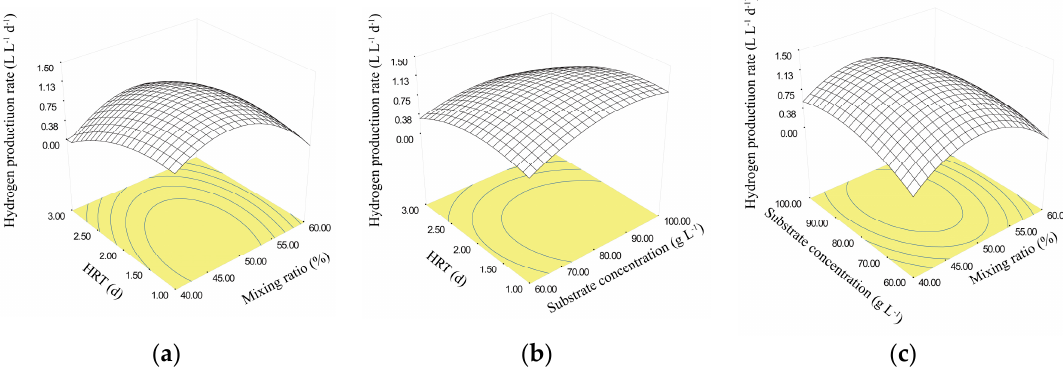
Figure 1. Three-dimensional (3D) response surface and two-dimensional (2D) contour plots for hydrogen production rate. ( a ) Mixing ratio and hydraulic retention time (HRT), ( b ) substrate concentration and HRT, and ( c ) mixing ratio and substrate concentration.